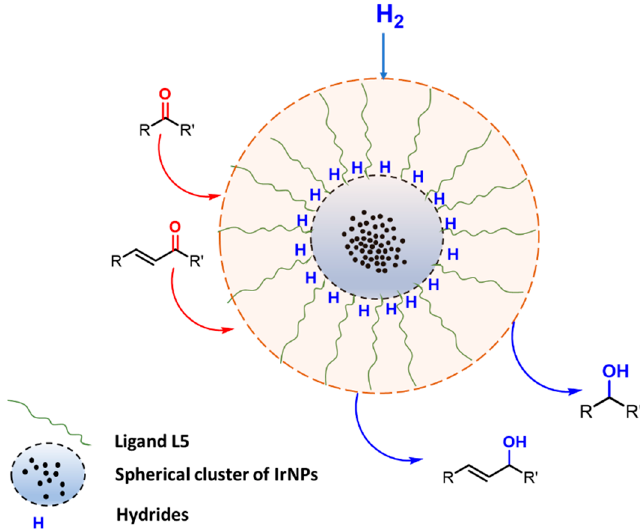
Figure 4. A representation of the supposed mechanism for the hydrogenation of carbonyl compounds via L5 -stabilised IrNPs.